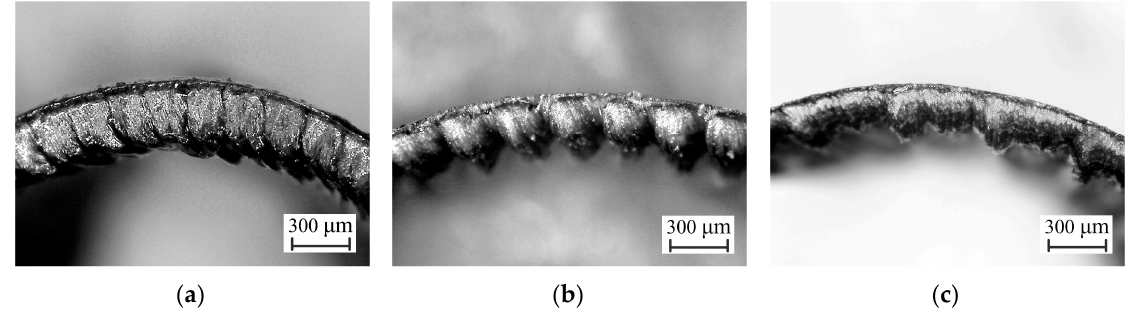
Figure 7. Chip morphology at maximum cutting radius edge: ( a ) central tooth, ( b ) intermediate tooth, ( c ) external tooth.